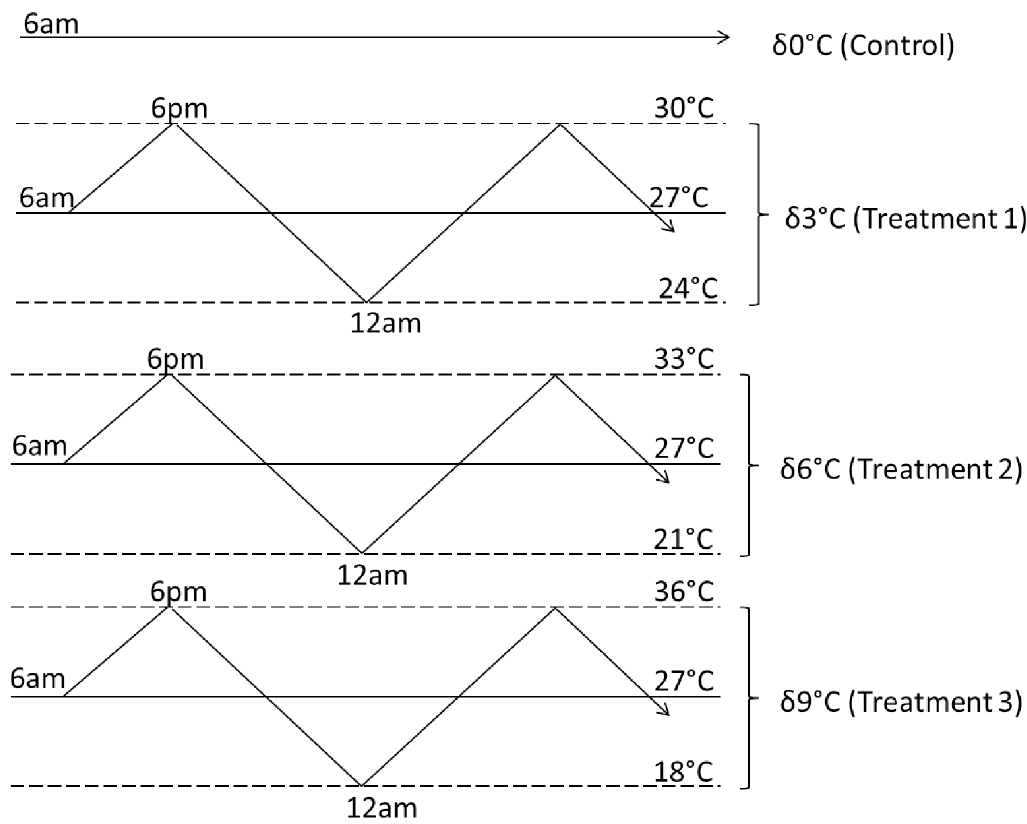
Fig 1. Schematic representation of acclimation treatments to variable temperatures at different amplitudes oscillating around an ambient mean temperature of 27˚C. The control ( δ 0˚C) was kept at benign 27˚C.